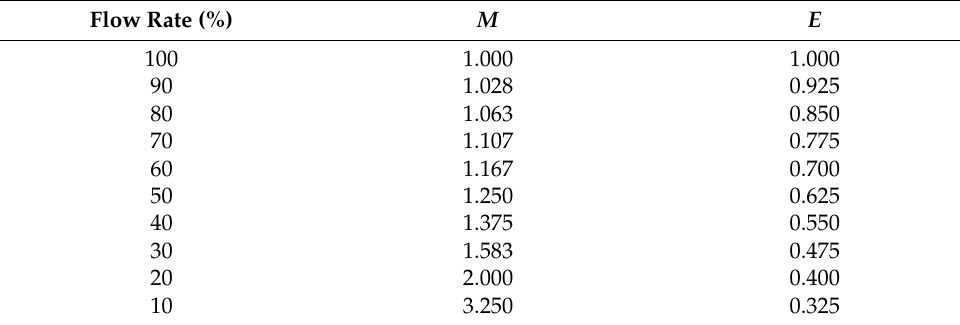
Table 2. Data for rotameters VA-40 (class